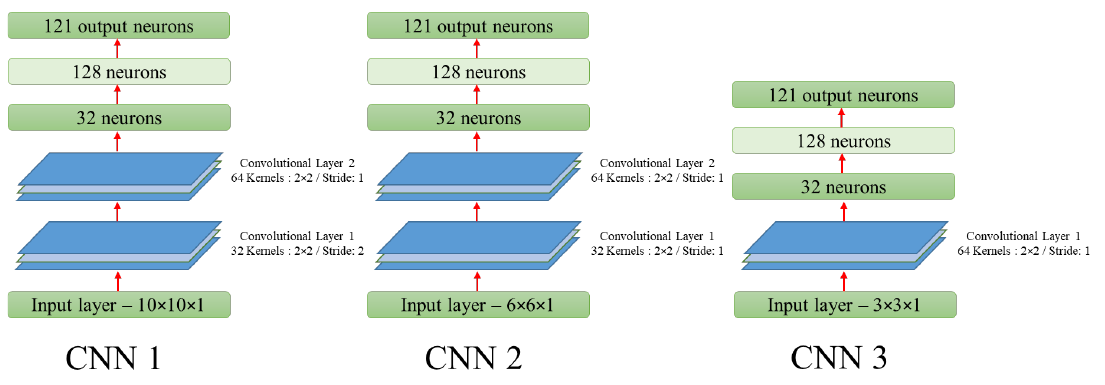
Figure 2. Three network configurations.